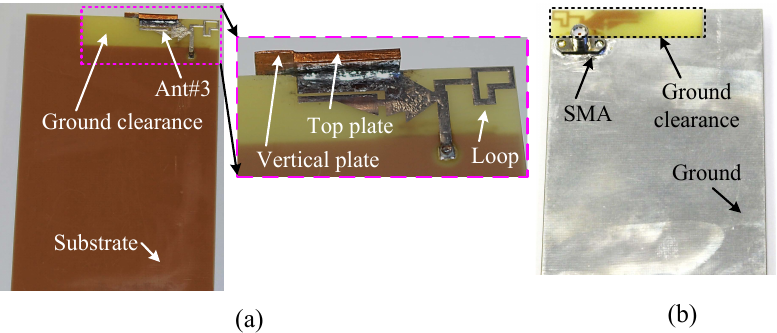
Figure 16. Fabricated wideband antenna (Ant#3) for mid and high bands: ( a ) top view of the antenna with whole mobile device substrate (antenna is shown in the inset), and ( b ) bottom view (whole